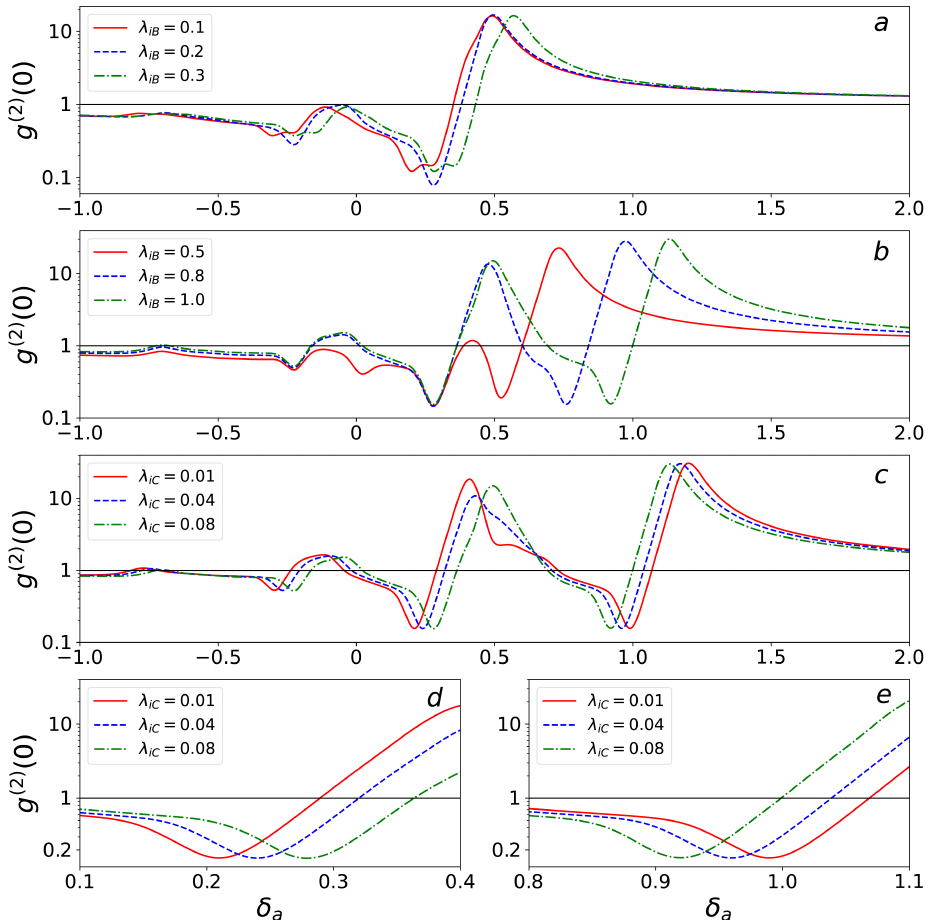
Figure 4. The equal-time SOC function g ( 2 ) ( 0 ) of the cavity field versus the driving detuning δ a for various values of the impurity–BEC interaction strength λ iB and impurity–cavity interaction strength λ iC : ( a ) λ iB = 0.1 (red solid line), λ iB = 0.2 (blue dashed line), λ iB = 0.3 (green dotdashed line), ( b ) λ iB = 0.5 (red solid line), λ iB = 0.8 (blue dashed line), λ iB = 1.0 (green dotdashed line), and ( c ) λ iC = 0.01 (red solid line), λ iC = 0.04 (blue dashed line), λ iC = 0.08 (green dotdashed line). √ √ = 1, λ = Other parameters are C e = C g = 2/2, λ s = 0.5, Ω b = 1, ω (cid:48) 2/2, η = 0.01, γ c = 0.1, CB i ( a ) λ iC = 0.08, ( c ) λ iB = 1.0 in units of Ω b . ( d , e ) are enlargements of the left and right dip positions in ( c